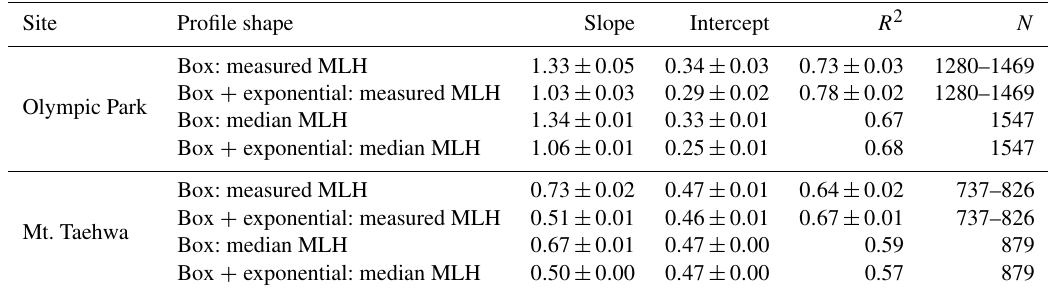
Table 4. Linear correlation between HCHO total columns from Pandora direct-sun measurements ( Y ) and columns calculated from in situ surface concentration measurements based on different profile shape assumptions ( X ). All measurements are averaged over 5min intervals. The least absolute residual fitting method is